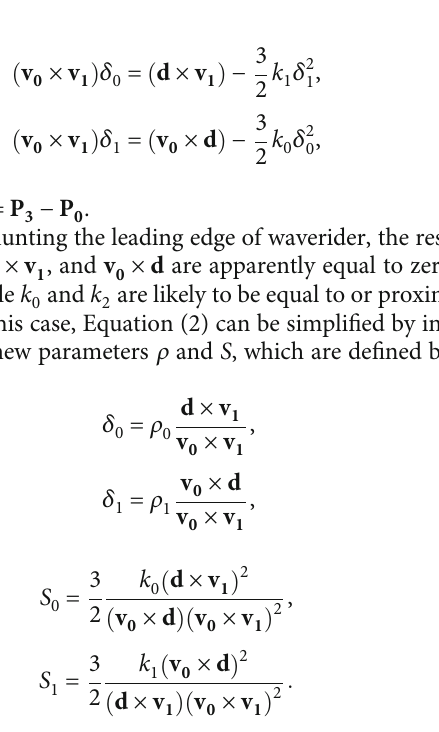
Figure 5: Di ff erence in the position of the new leading-edge point: (a) G 0 method (black); (b) G 2 method (red).